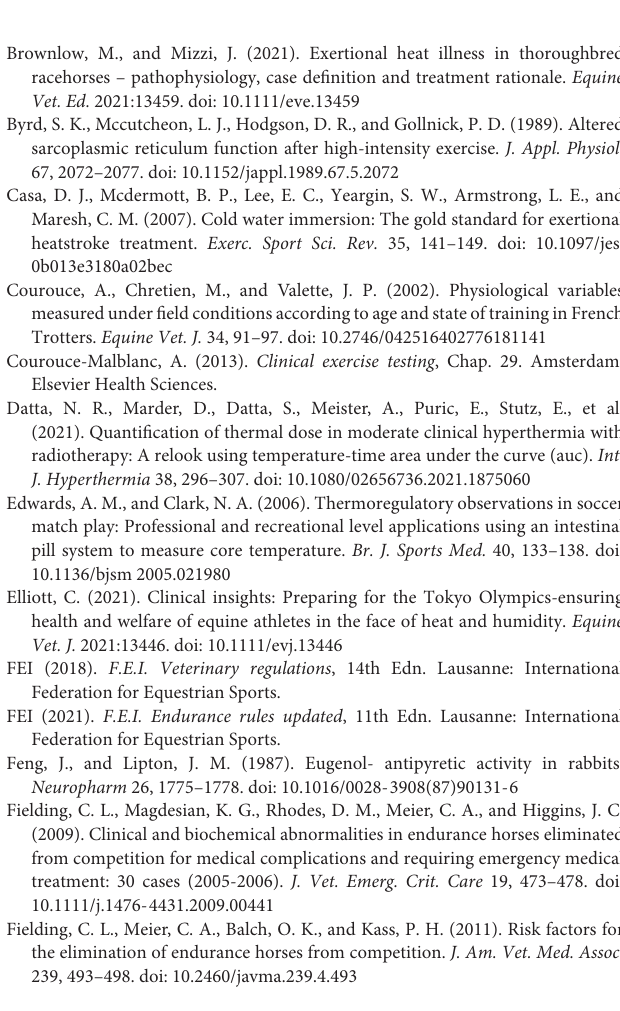
Supplementary Table 1 | T c parameters in endurance exercise (per 40 km) and trotter